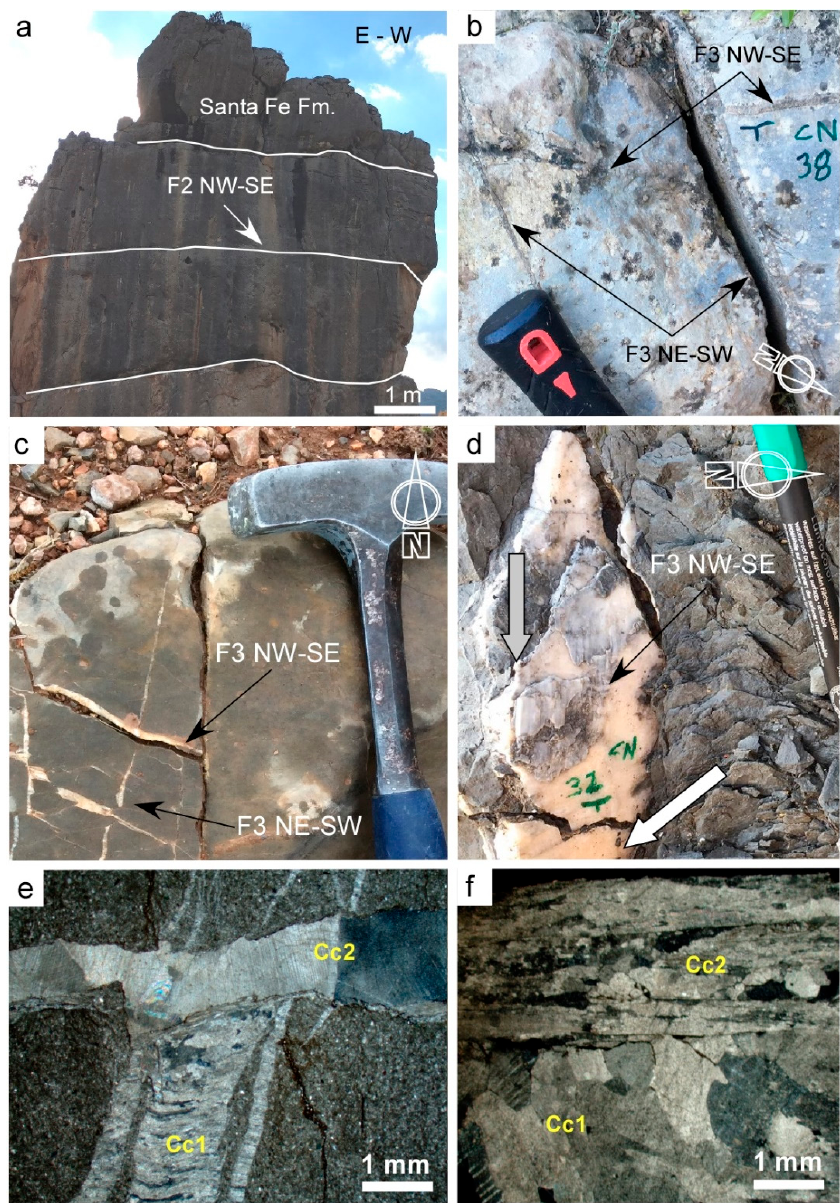
Figure 8. ( a ) F2: NW-SEnon-mineralized fractures in the Santa Fe Formation. ( b , c ) F3: NW-SE and NE-SW conjugate fracture set. ( d ) F3 fracture showing a later reactivation with strike-slip movement (white arrow) and dip-slip movement (grey arrow). ( e , f ) Crosscutting relationship between calcite cements Cc1 and Cc2 (sample CN12). Cc2 clearly crosscuts and postdates Cc1 in F3 conjugate joints.